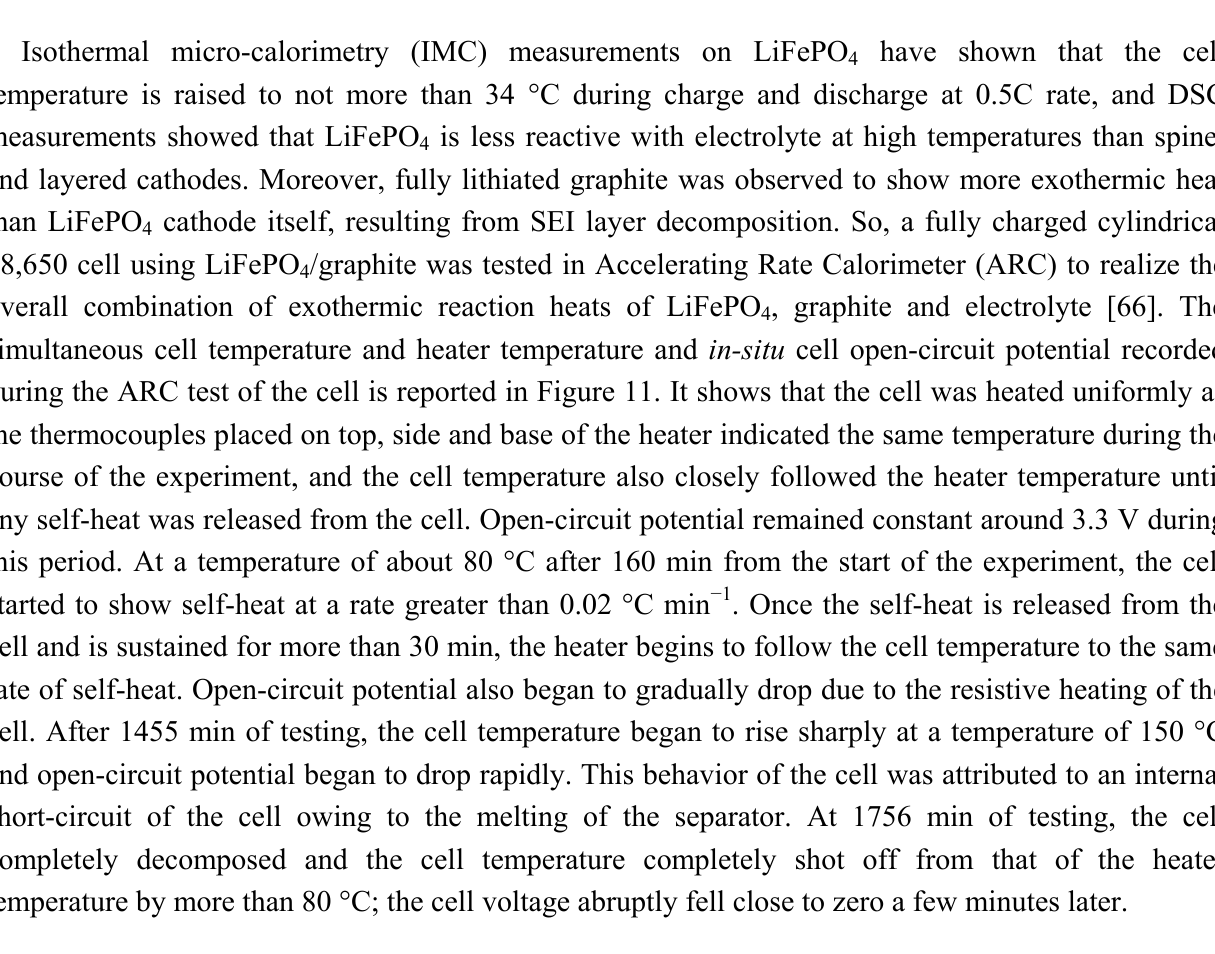
Figure 11. Cell temperature measured at side, top and base of the heater (the curves are superposed) and in-situ open-circuit potential chronological record of LiFePO 18,650 cell subjected to an ARC test